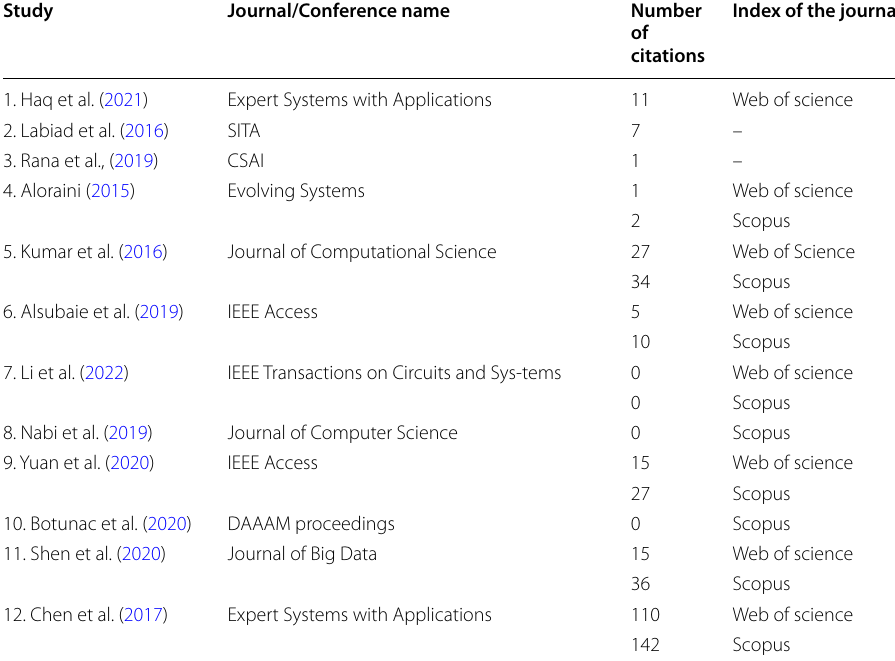
Table 5 Analysis of reviewed studies based on the number of citations and index of the journal